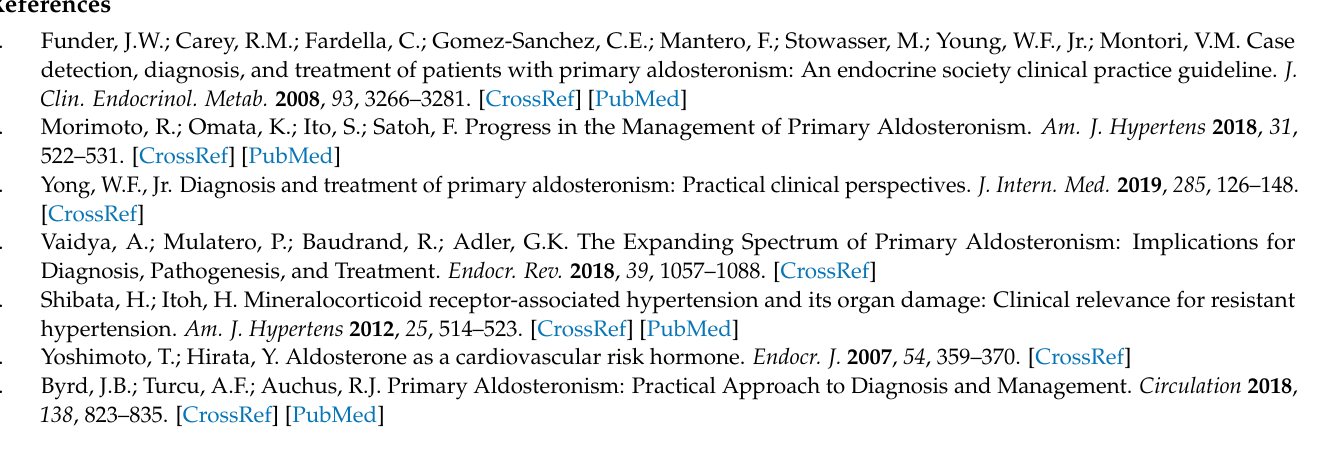
Figure S3: Linearity of aldosterone measured in plasma samples using CLEIA with the improved reagent; Table S7: Recovery of aldosterone measured using CLEIA with the improved reagent; Table S8: Interference in the aldosterone concentration data obtained using CLEIA with the improved reagent; Table S9: Cross-reactivity of the aldosterone concentrations obtained using CLEIA with the improved reagent; Figure S4: Hook effect of aldosterone using CLEIA with the improved reagent; Figure S5: Results of the Passing–Bablok regression and Bland-Altman